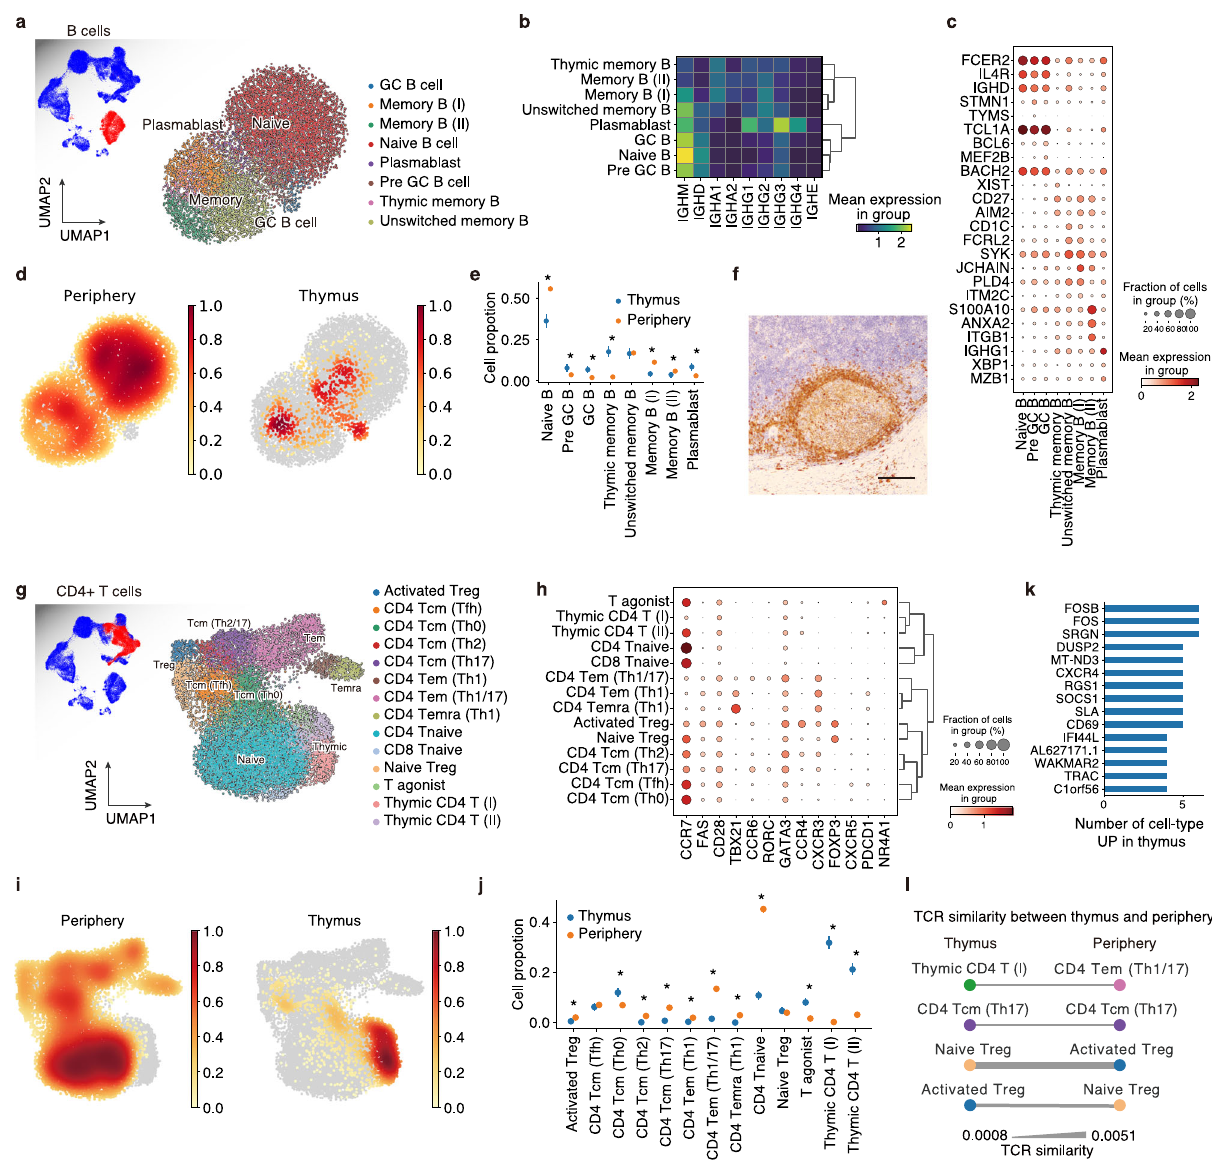
Fig. 4 Immune cell landscape elucidates GC formation, T H 0-T FH enhancement, and Treg recirculation in MG-type thymoma. a UMAP embedding for B cell clusters of thymoma and peripheral blood. b Heatmap of immunoglobulin expressions in each B cell cluster. Mean expressions in each group are shown as a heatmap. c Dot plot of gene expression of marker genes of each B cell cluster. d Density plots showing B cell accumulation in the periphery (left) and thymus (right). e Cell proportion of each B cell cluster in thymoma and peripheral blood. Periphery n = 2, Thymoma n = 4. Error bars show 98% highest density interval. * FDR < 0.05. (Methods) f Representative IHC image of germinal center in MG-thymoma stained for CD79A. Scale bar: 100 µ m. The presence of GC was also checked in Fig. 6j and Source Data. g UMAP embedding for CD4 + T-cell clusters of thymoma and peripheral blood. h Dot plot of gene expression of marker genes of each T-cell cluster. i Density plots showing T-cell accumulation in the periphery (left) and thymus (right). j Cell proportion of each T-cell cluster in thymoma and peripheral blood. Periphery n = 2, Thymoma n = 4. Error bars show 98% highest density interval. Center points represent the mean of the posterior distributions. * FDR < 0.05. (Methods) k Bar plot of thymus speci fi c genes across CD4 + T-cell clusters ranked by the number of cell types where each gene was upregulated ( P adj < 0.05 and log 2 fold change > 1) in mature CD4 + T cells. l TCR similarity between peripheral blood and thymoma. The thicknesses of edges represents TCR similarity. * FDR < 0.05 in e and j . Statical procedures in e and j are described in Methods. GC germinal